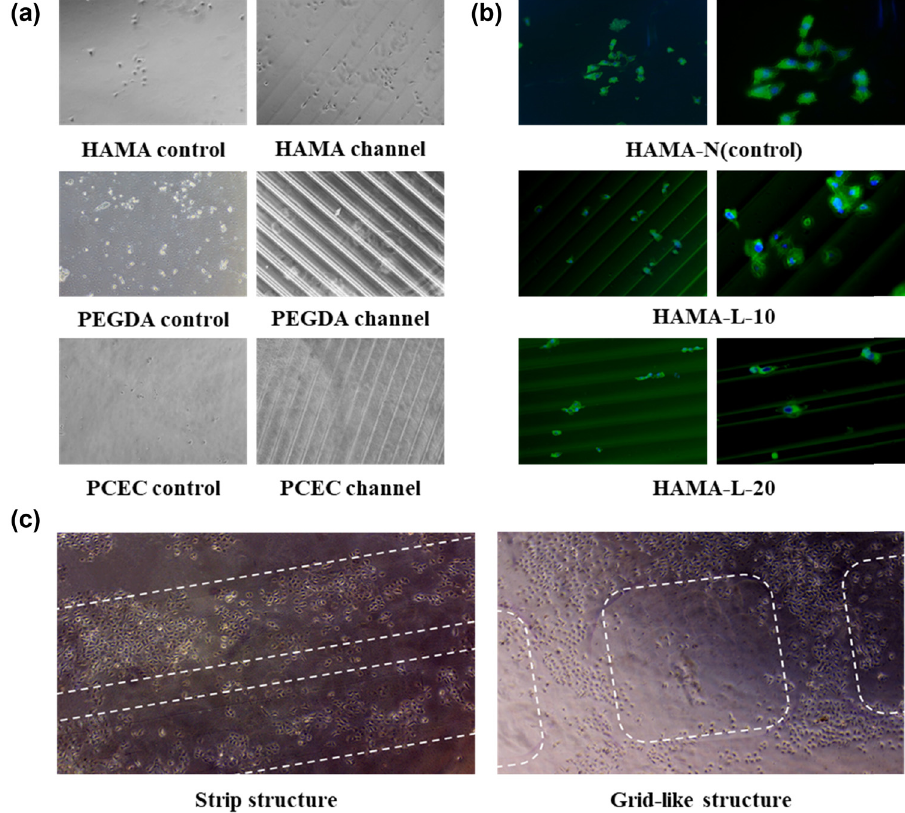
Figure 6: In fl uence of surface microstructure on cell growth morphology. ( a ) Growth of HUVE cells on the smooth surface and microstructure surface of HAMA - gel, PEGDA, and PCEC - derived materials after 48 h culture. ( b ) E ff ects of di ff erent channel widths on the surface of HAMA - gel on cell growth and morphology by immuno fl uorescence staining, the right pictures are the magni fi cations of the left. ( c ) Culture of HUVE cells on inkjet printer HAMA - gel materials, cell growth after 48 h: ( left ) strip structure; ( right ) grid - like